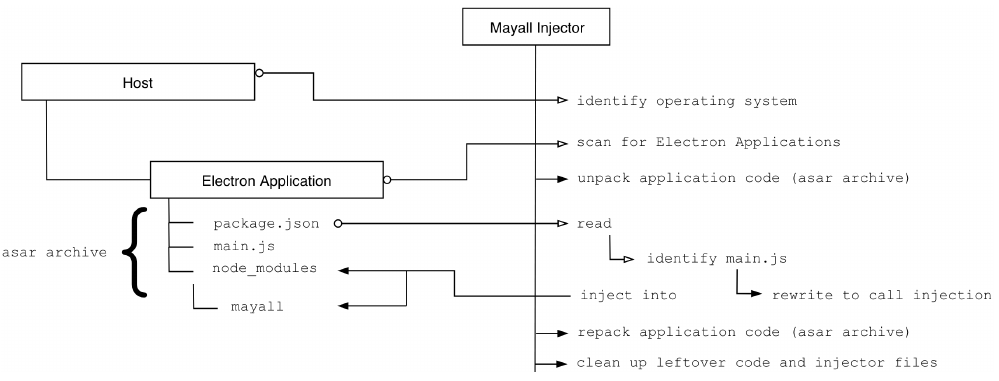
Figure 4. Flow of execution for injecting malicious modules into trusted Electron